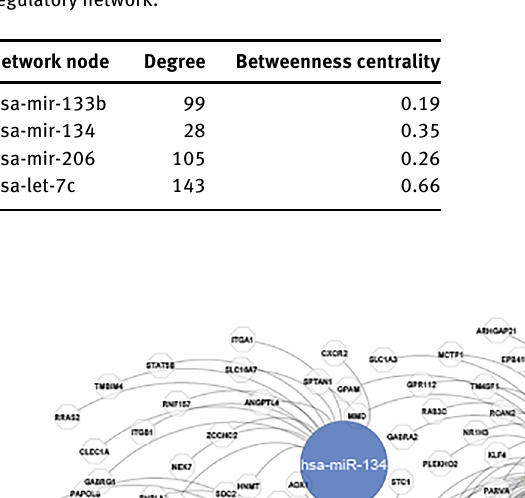
Table 1: Integrative analysis of gene-miRNA regulatory network.